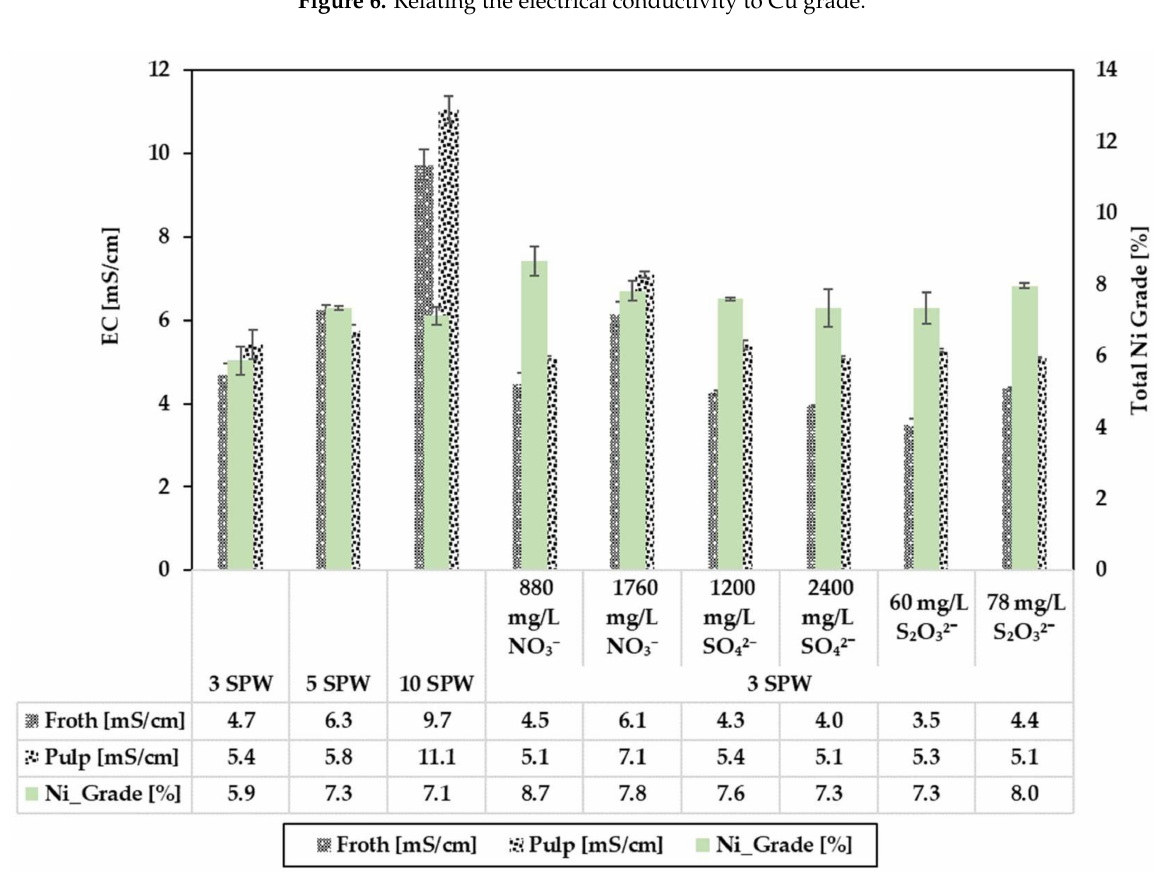
Figure 6. Relating the electrical conductivity to Cu grade.